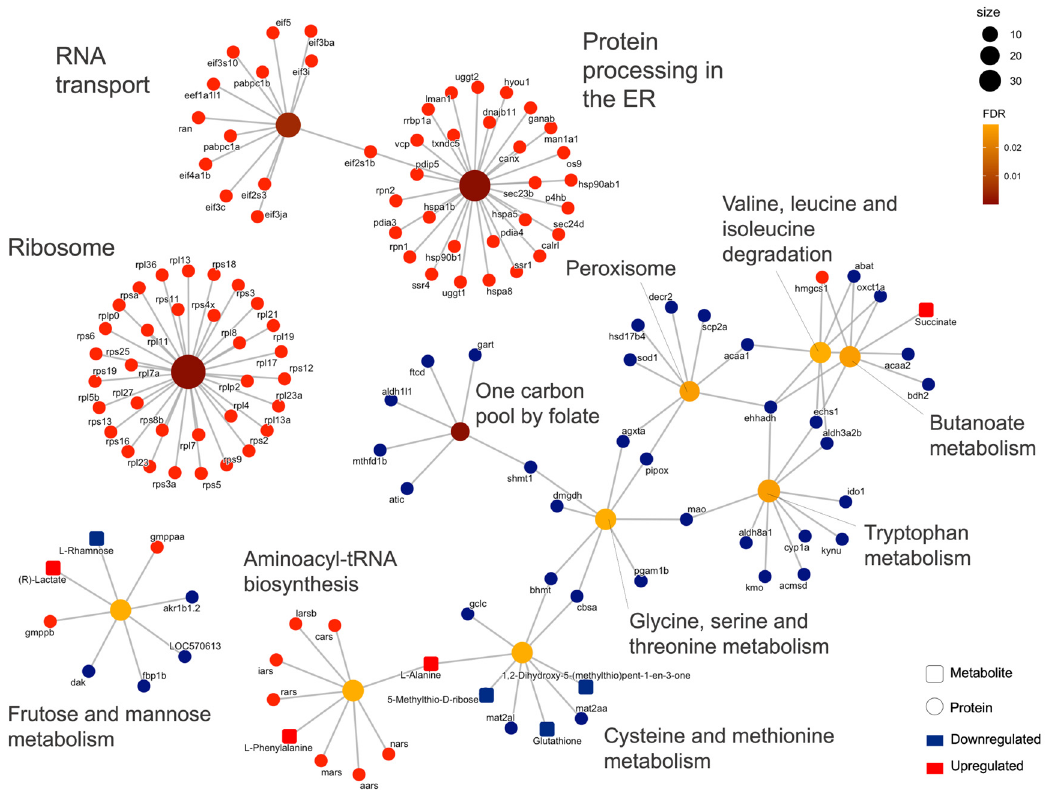
Figure 2. A gene-concept network of enriched KEGG terms (FDR < 0.05) within the differential abundant proteins (DAPs) and metabolites (DAMs) identified in the liver of gilthead seabream subjected to the net-handling (NET) challenge. Central nodes represent the enriched term, with color and size representing FDR and the number of associated biomolecules, respectively. The concept nodes represent biological concepts, where shape corresponds to the omics modality and color to the regulation of that biomolecule, determined by Student’s t -test with FDR controlled at 0.05.